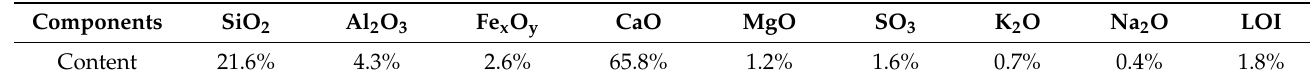
Table 2. Chemical components of cementitious materials.